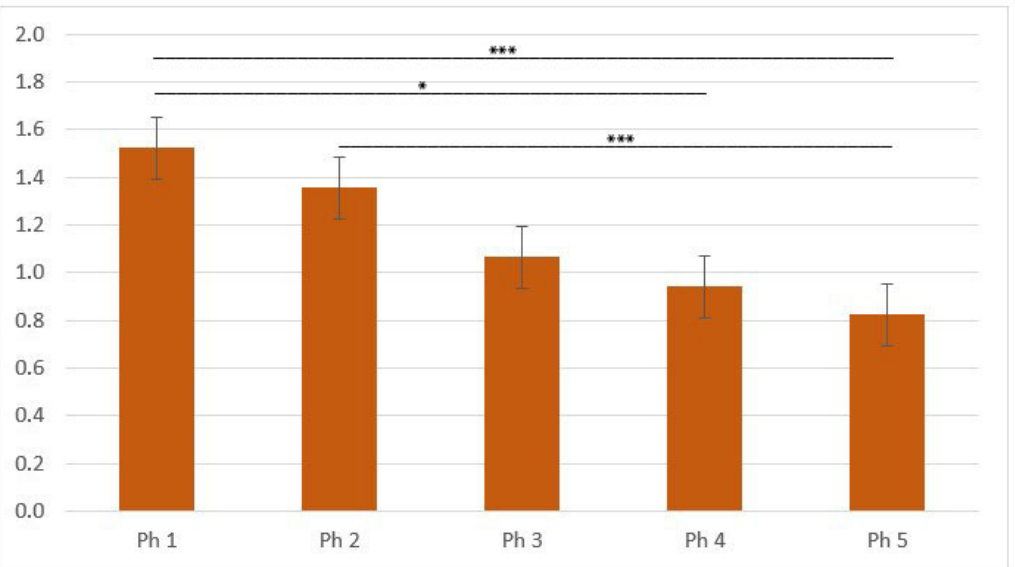
Figure 7. Area percentage scores of KIF12 in human fetal and postnatal kidneys. To quantify protein product expression, 20 non ‐ overlapping representative visual fields per DAB ‐ stained sample were captured. Phase one (Ph1), phase two (Ph2), phase three (Ph3), phase four prenatal (Ph4) and postnatal phase (Ph5). Data were presented as the mean ± SE (vertical line) and analyzed by the one-way ANOVA test with Tukey’s multiple comparisons test. Significant differences were indicated by * p < 0.05 and ** p <